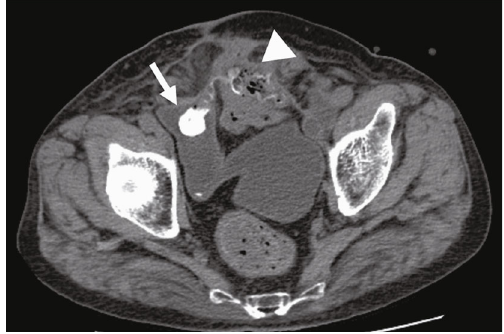
Figure 2: Abdominal computed tomography (CT) scan on arrival: the mesh migrated into the neobladder (arrow) and the small intestine